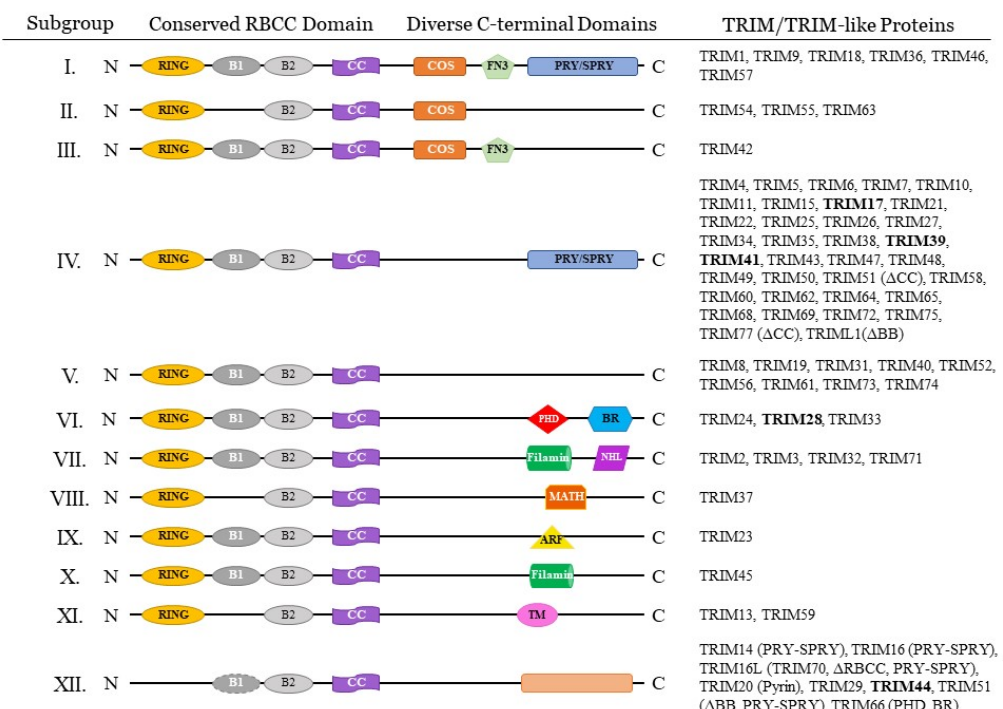
Figure 1. Classification of the TRIM proteins family. In bold, TRIM17 and its known TRIM partners described in this review. Adapted from [19,20].